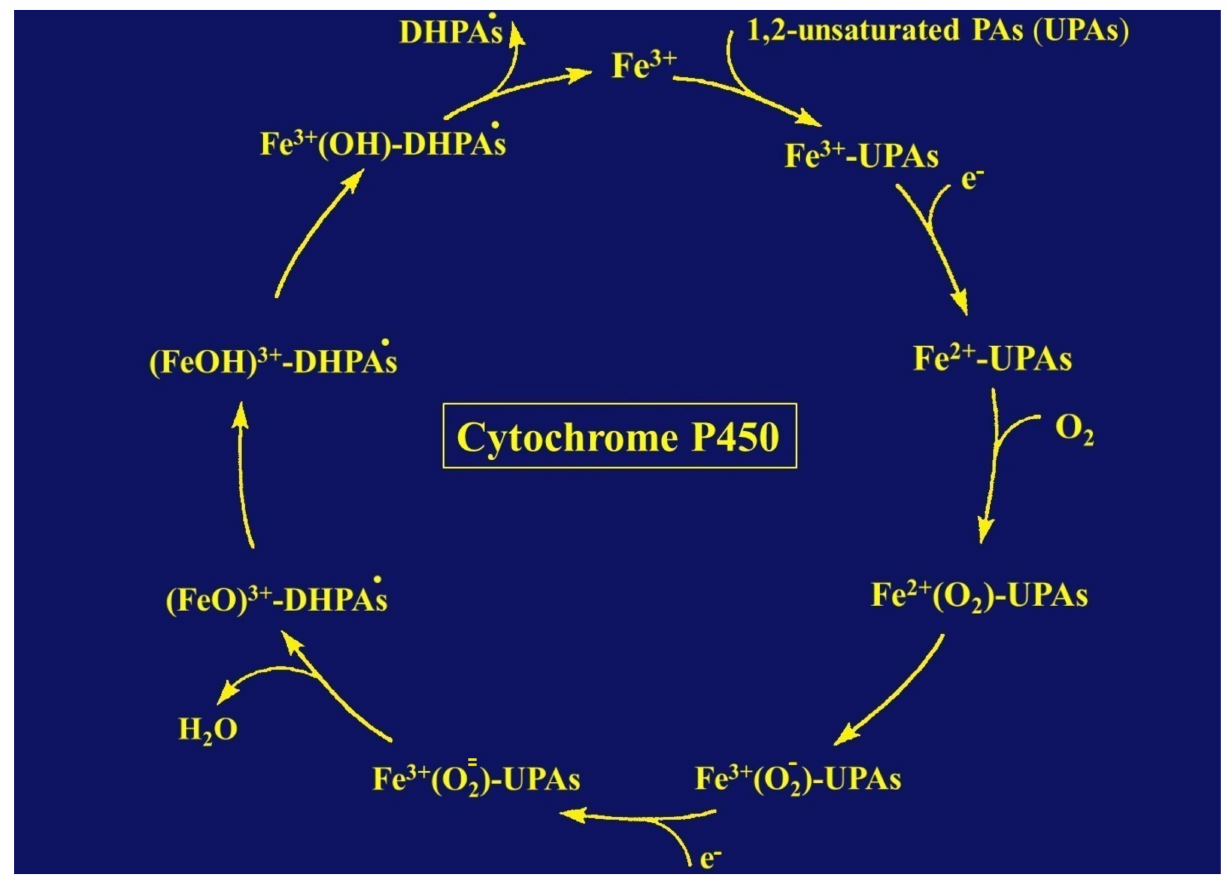
Figure 7. Proposed catalytic cytochrome P450 cycle implicated in the toxification of 1,2-unsaturated PAs. In analogy to drugs, ethanol and other exogenous compounds, the 1,2-unsaturated PAs (UPAs) enter the catalytic cytochrome P450 cycle as substrate to be metabolized, shown on top of the cycle right side. After several steps, the metabolized UPA leaves the cycle as toxic radical DHPA • , whereby the 1,2-unsaturated PA loses its double bond and changes to pyrrole protein adducts. CYP stands for its various isoforms. As a reminder, regarding cytochrome P450, the term “P450” was used to describe a “pigment” with an absorption maximum at 450 nm within the ferrous-carbon monoxide complex of CYP in rat liver microsomes [191]. The figure was modified and retrieved from an open access report of Teschke and Danan